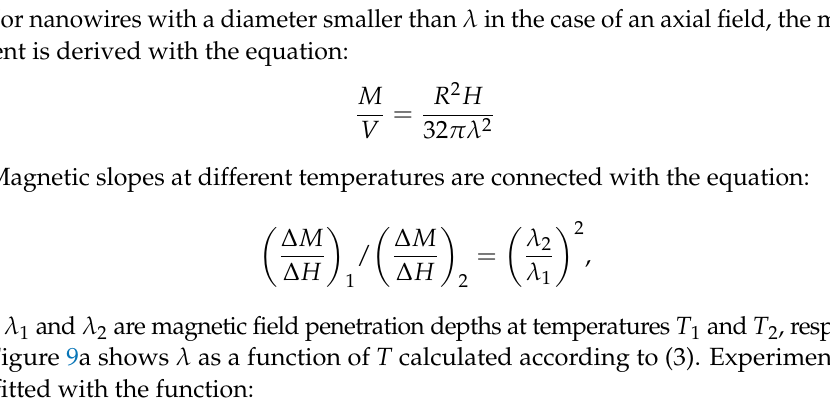
Figure 8. The slope of the linear part of M ( H ) curve observed at small fields for s45 ( a ) and s200 ( b